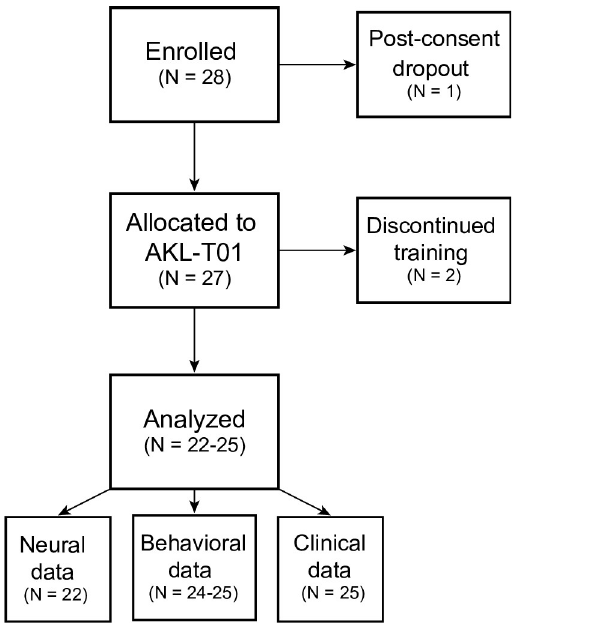
Fig 1. CONSORT flow